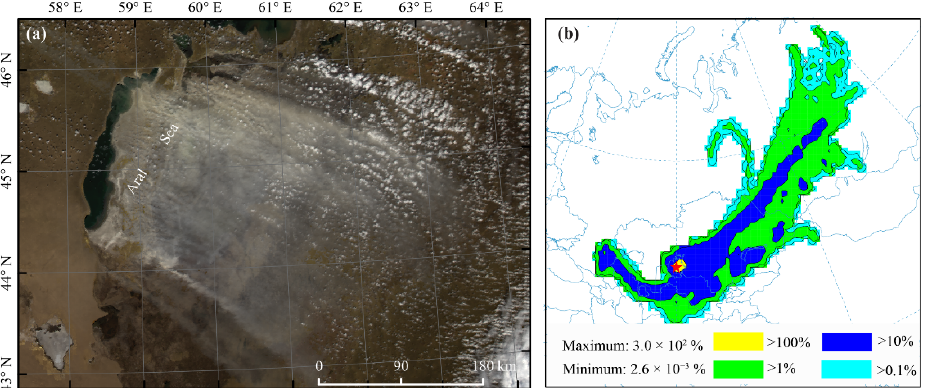
Figure 9. Sand and dust storm that occurred on 25 April 2014 captured by MODIS ( a ) and potential long ‐ range transport of the atmospheric aerosols from the Aral Sea Basin, derived from HYSPLIT model ( b ).